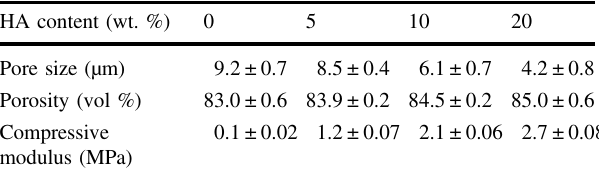
Fig. 3 Scheme representation of composite scaffold by freeze-drying method involves the preparation of an emulsion created by homo- genization of a mixture of the polymer solution, and a water phase, where the continuous phase has the polymer-rich solvent and the Table 1 Pore size, porosity, and compressive modulus of PCL/HA composite scaffolds produced with various HA contents (0, 5, 10, and 20 wt %) [64] HA content (wt. %)